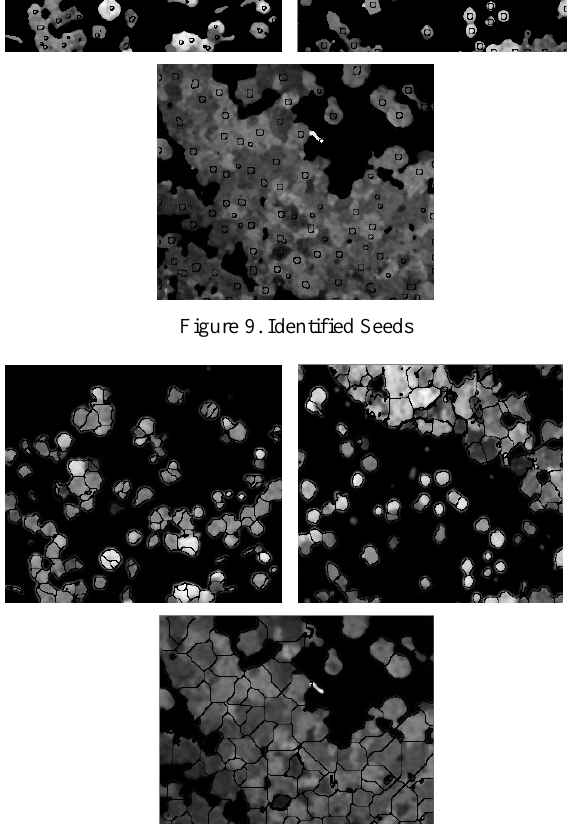
Figure 10. Segmented crowns using spectral and structural constraints- Zone 1 (Top Left), Zone 2 (Top Right) and Zone 3 (Bottom)